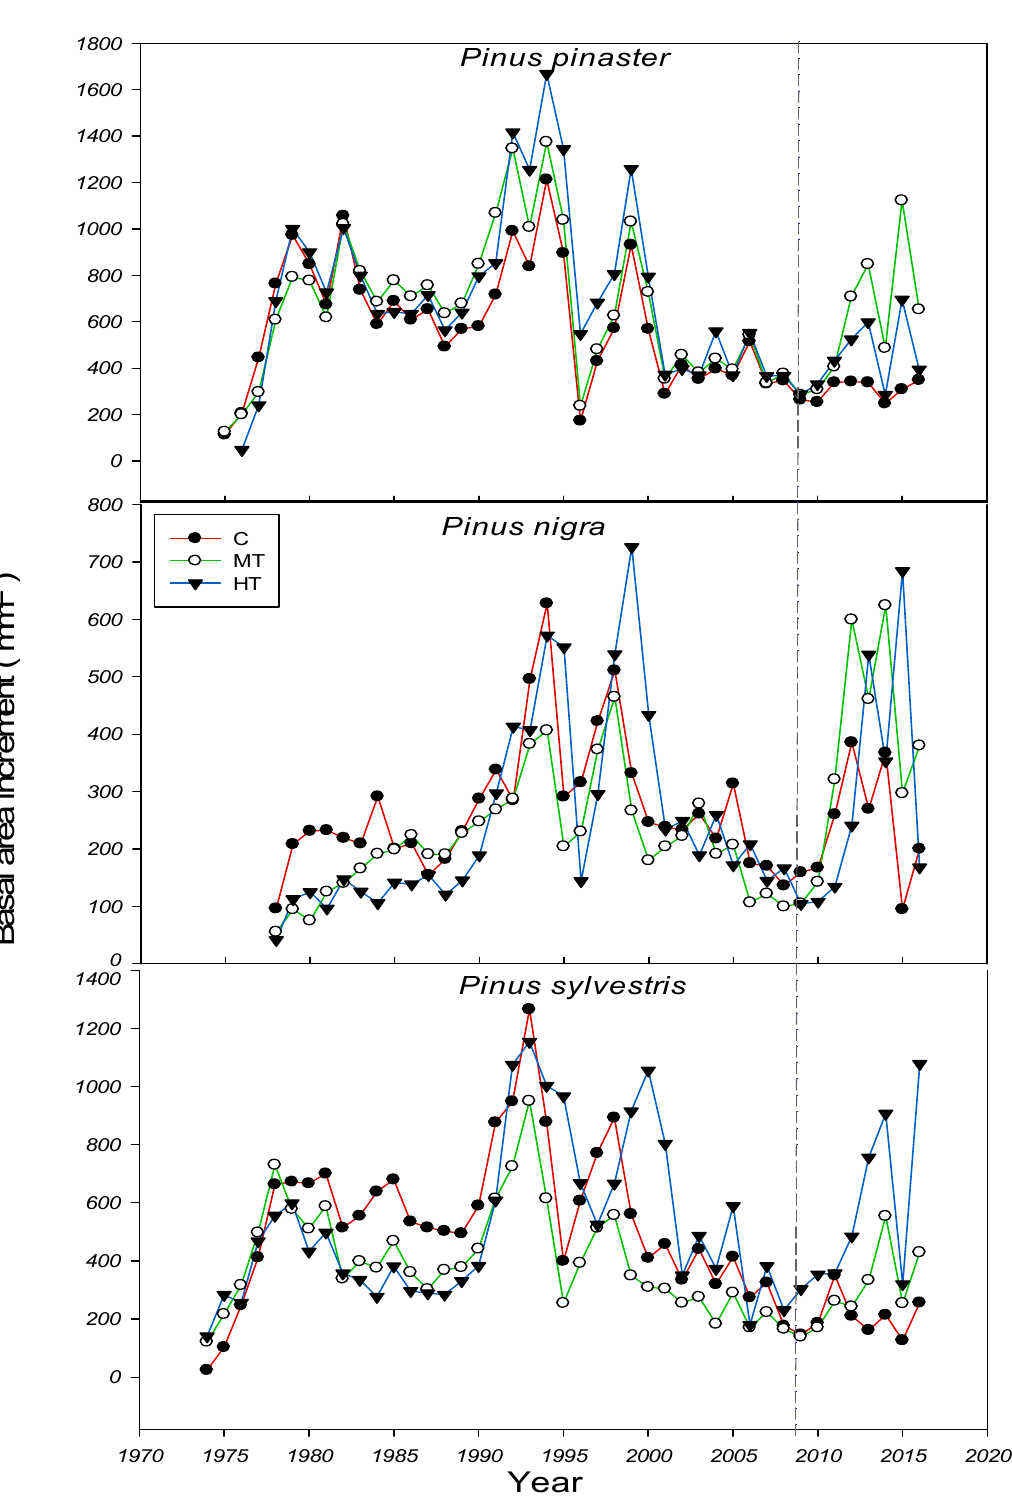
Figure 2. Mean curves of basal area increment (BAI) chronologies for Pinus pinaster , Pinus nigra and Pinus sylvestris . The vertical, dashed line corresponds to the 2008 thinning year. Treatments: C—control (0% BA removed); MT—moderate thinning (30% BA removed); HT—heavy thinning (60% BA removed).